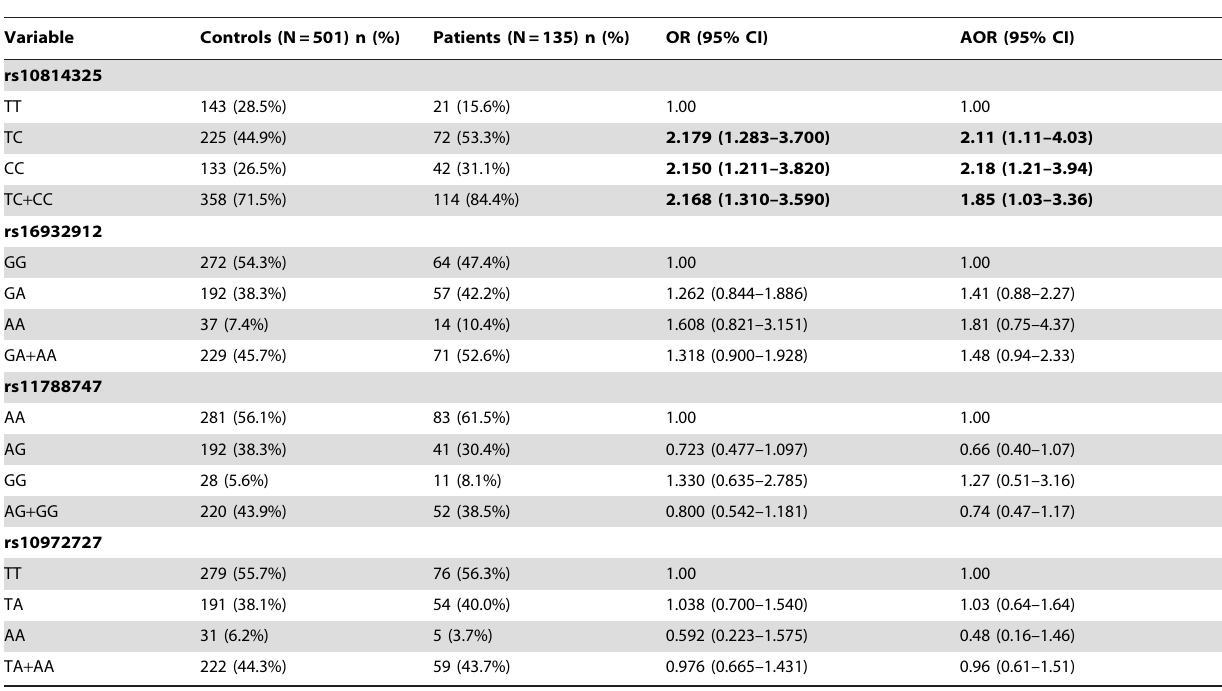
Table 3. Adjusted odds ratio (AOR) and 95% confidence interval (CI) of HCC associated with RECK genotypic frequencies.